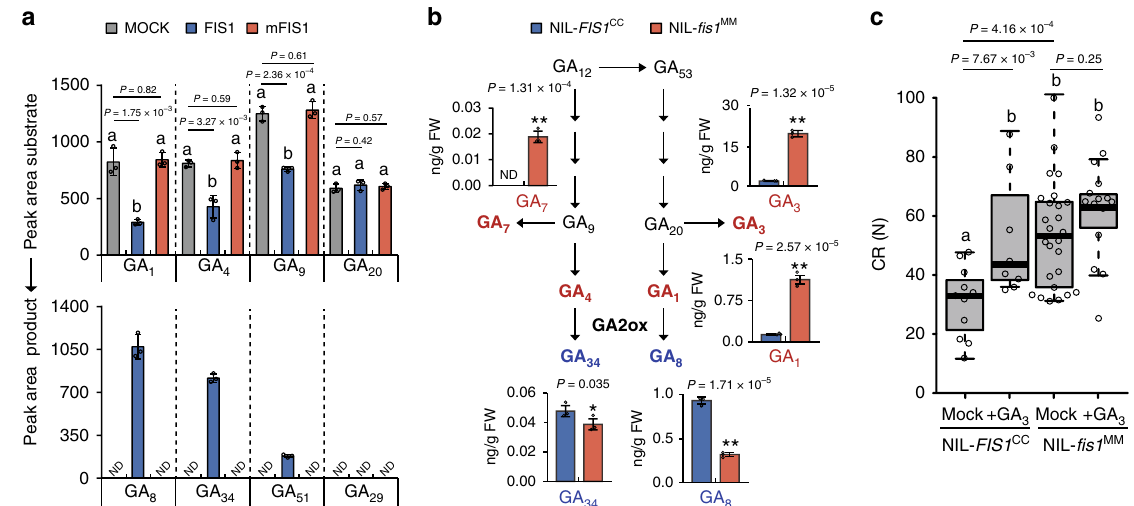
Fig. 3 FIS1 regulates fruit fi rmness via the GA catabolism mediated pathway. a Enzymatic activities of recombinant FIS1 and mFIS1 proteins. mFIS1, mutated FIS1. Error bars, mean ± SD. n = three biological replicates. Different letters represent signi fi cant differences according to the Tukey – Kramer test ( P < 0.05). b The endogenous levels of gibberellins in NIL- fi s1 MM and NIL- FIS1 CC red ripe fruit pericarp. Error bars, mean ± SD. n = three biological replicates. The asterisks indicate a statistically signi fi cant difference (two-tailed Student ’ s t -test, * P < 0.05, ** P < 0.01). c CR of GA-treated or untreated NIL - fi s1 MM and NIL- FIS1 CC red ripe fruit s . GA was applied at the mature green stage. n = 11, 8, 26, and 15 fruits. Box edges represent the 0.25 and 0.75 quantiles, and bold lines indicate median values. Whiskers indicate 1.5 times the interquartile range. Different letters represent signi fi cant differences according to the Tukey – Kramer test ( P <